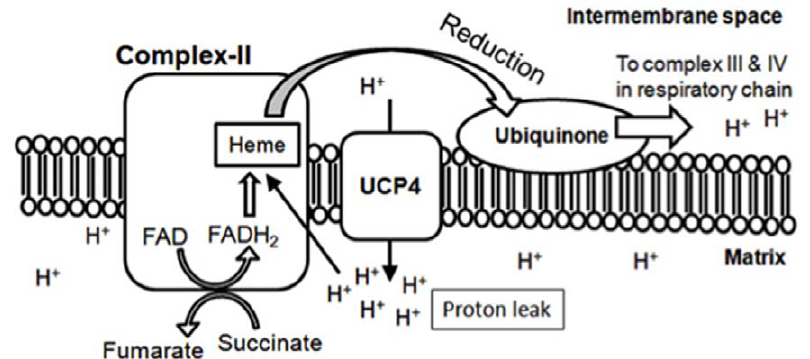
Figure 8. Hypothetical model showing potential role of UCP4-mediated proton leak in facilitating Complex II-mediated oxidative phosphorylation and ATP synthesis. UCP4 may span in close proximity to Complex II on the mitochondrial inner membrane to increase regional proton concentration in the matrix, and facilitate subsequent reduction of ubiquinone (UQ) via heme-group to increase Complex II activity. Proton leak via UCP4 may increase regional proton supply near Complex II, which boosts proton transport in the downstream respiratory Complex III and IV. Net effect is a facilitation of high-energy electron flow along the respiratory chain to increase ATP synthesis.